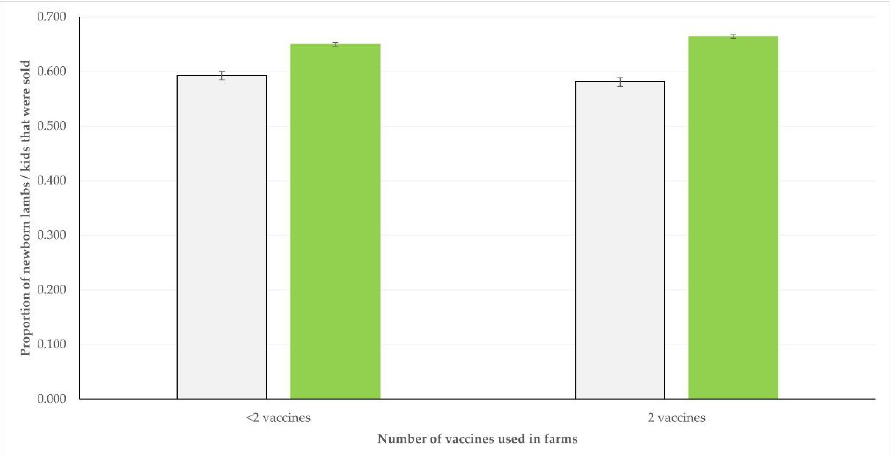
Figure 4. Proportion of newborns that were sold of those born, in sheep flocks (green) or goat herds (grey) in Greece, according to the total number of vaccines against two infections that might lead in death of affected newborns, which were used in the farms (bars show 95% CIs).